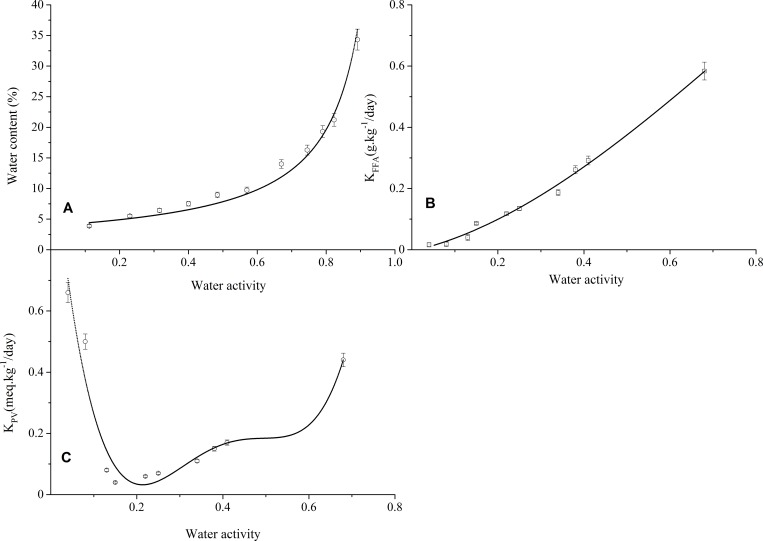
The sorption isotherms and rancidification rate of WG samples during storage.sorption isotherms, (B) hydrolytic rate and (C) oxidative rate.